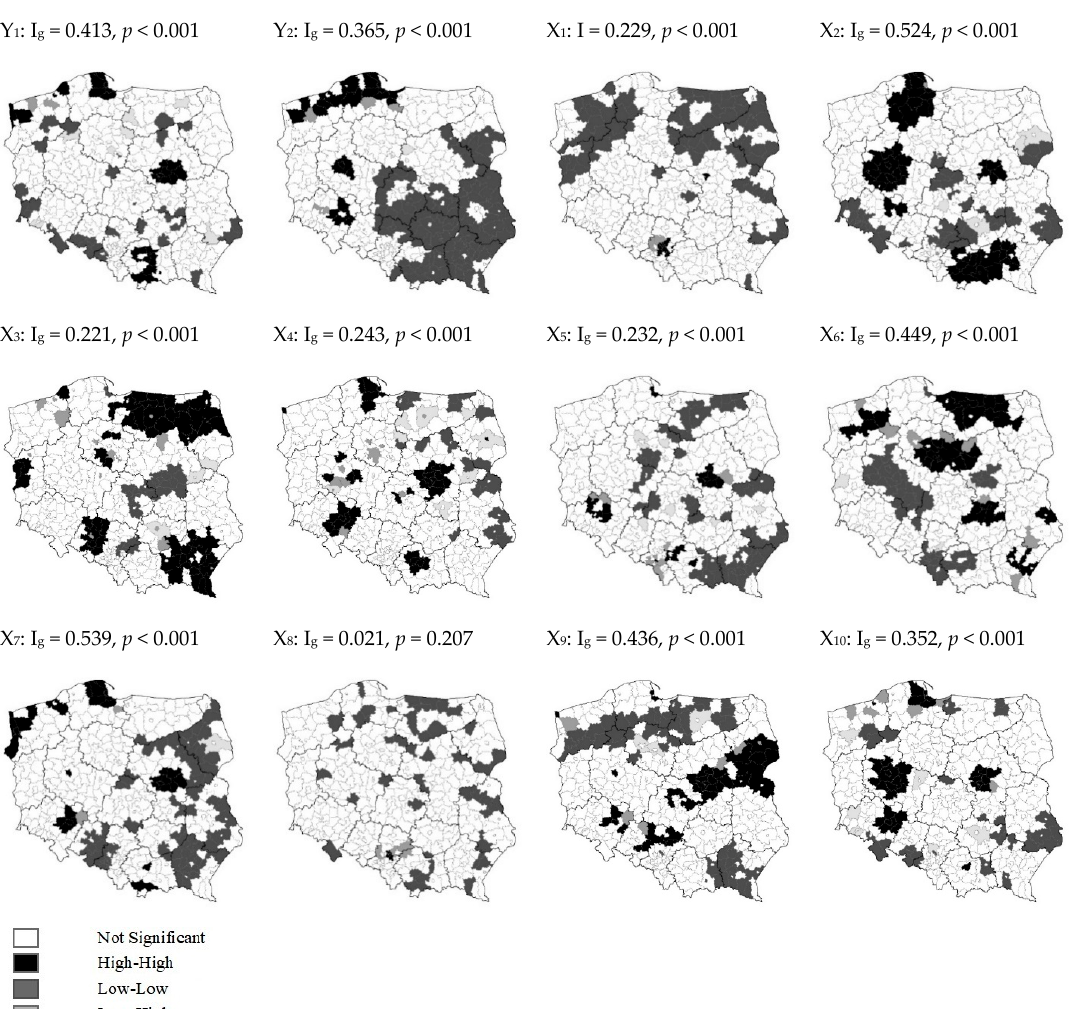
Figure 2. Local and global statistics of Moran’s I. Source: own research based on GUS data. Source: own